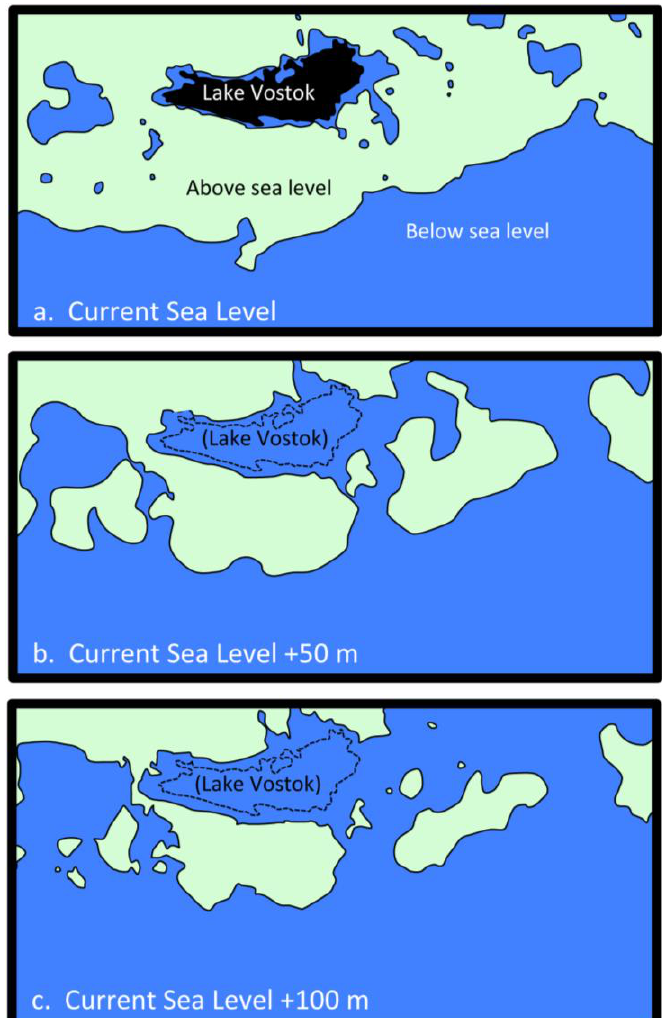
Figure 4. Sea level changes relative to the current level of water in Lake Vostok (based on reference [24]). ( a ) Current mean sea level. Blue indicates areas below sea level if all of the ice was removed. Light green indicates areas above sea level. The upper surface of Lake Vostok (black region) is approximately 200 m below current sea level; ( b ) View of the same region with a 50 m sea level rise. Current outline of Lake Vostok is indicated by the dashed line; ( c ) View of the same region with a 100 m sea level